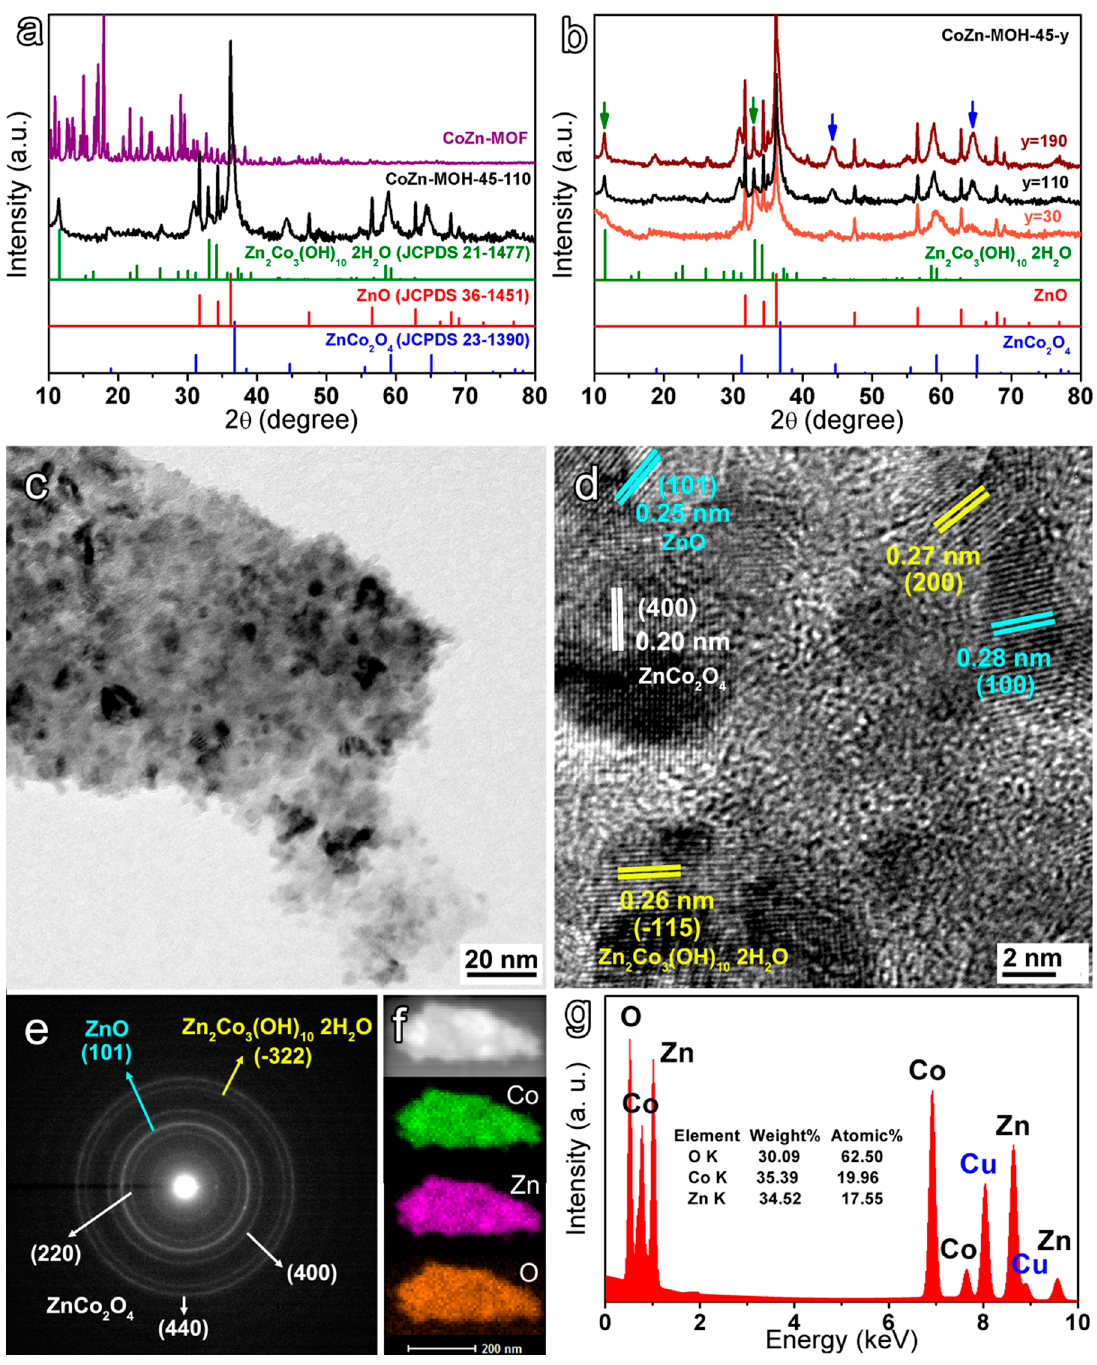
Figure 3. Comparisons of XRD patterns: ( a ) CoZn-MOF-45 and CoZn-MOH-45-110 powders; ( b ) CoZn-MOH-45-y powders; ( c,d ) TEM images of CoZn-MOH-45-110; ( e ) the selected area electron diffraction pattern of (c); ( f ) TEM elemental mapping; and ( g ) energy dispersive X-ray spectroscopy (EDS) spectrum of CoZn-MOH-45-110, where the Cu signal comes from the sample